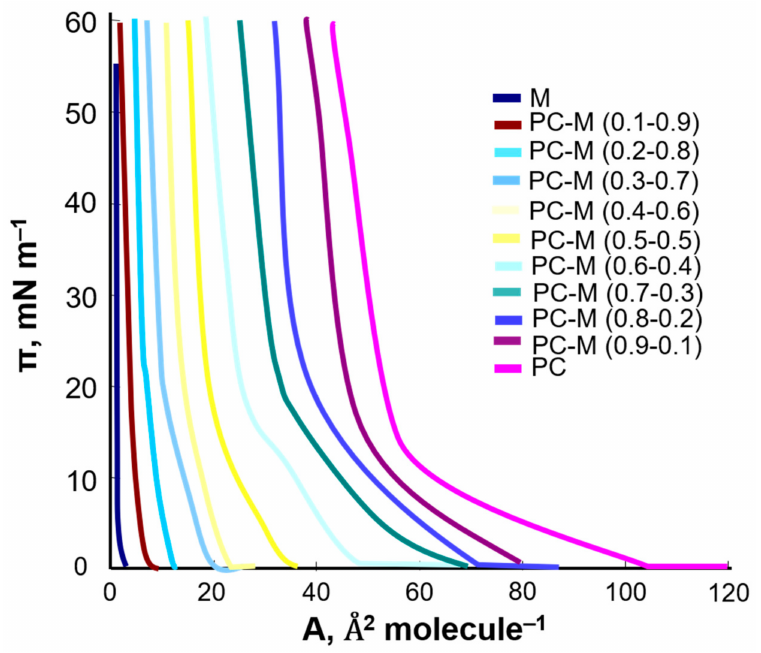
Figure 9. Surface pressure–area ( π –A) isotherms of mixed PC–M